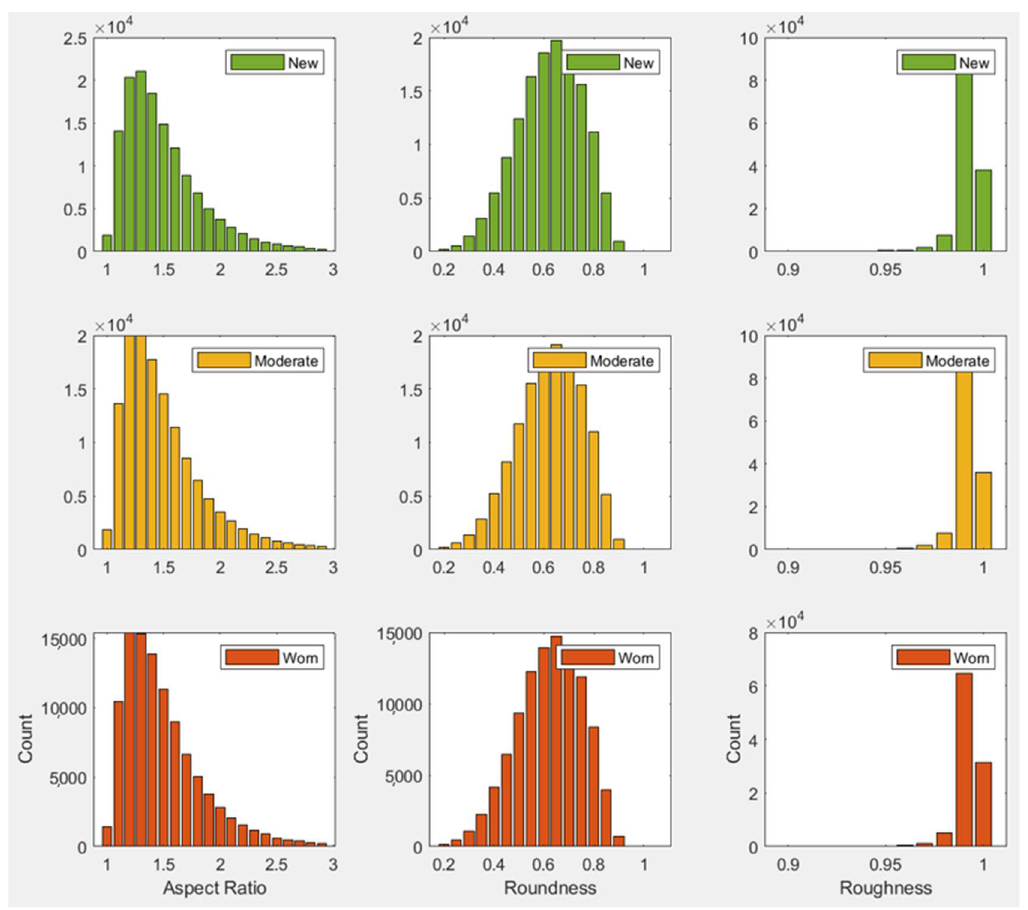
Figure 9. The aspect ratio, roundness, and roughness values calculated and represented in histo- grams for the deposited particles generated from the three different pick wears.